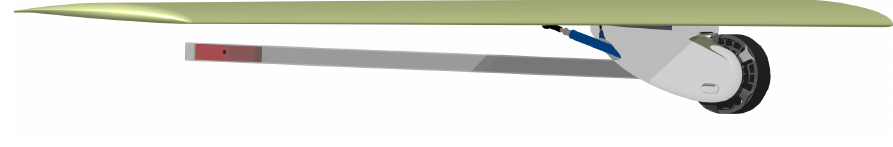
Figure 3. CAD rendering of the flutter suppression actuator.